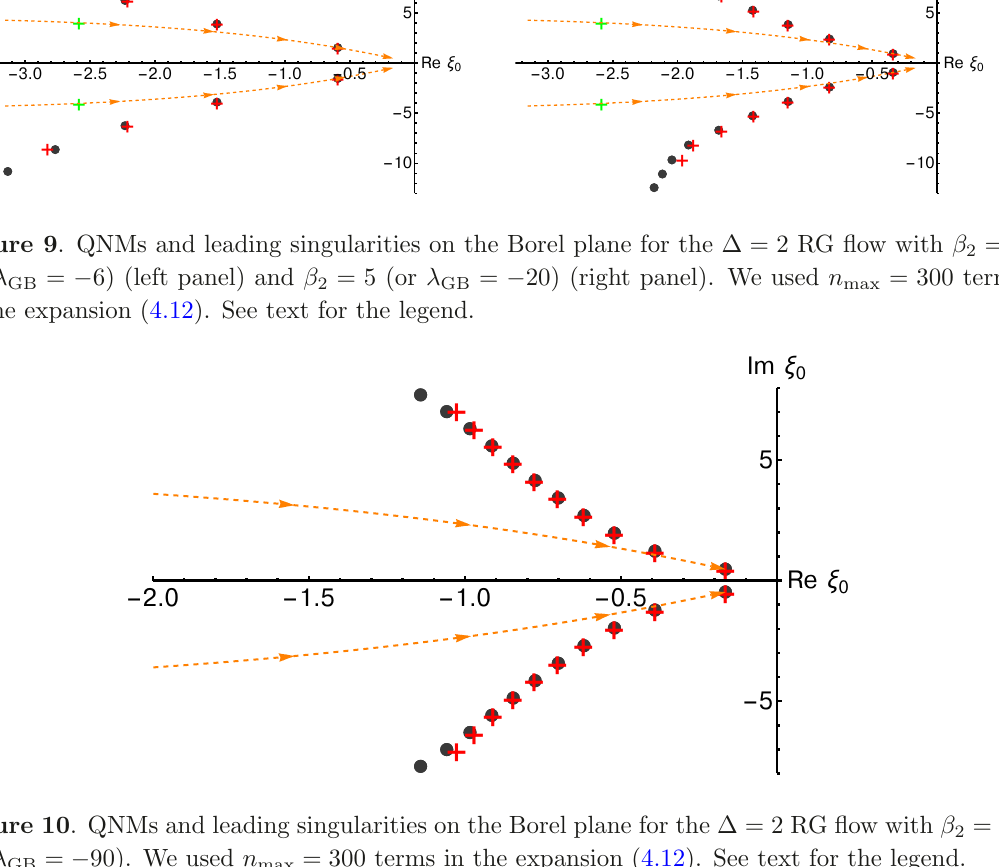
Figure 10 . QNMs and leading singularities on the Borel plane for the ∆ = 2 RG flow with β 2 = 10 (or λ GB = 90). We used n max = 300 terms in the expansion (4.12). See text for the −